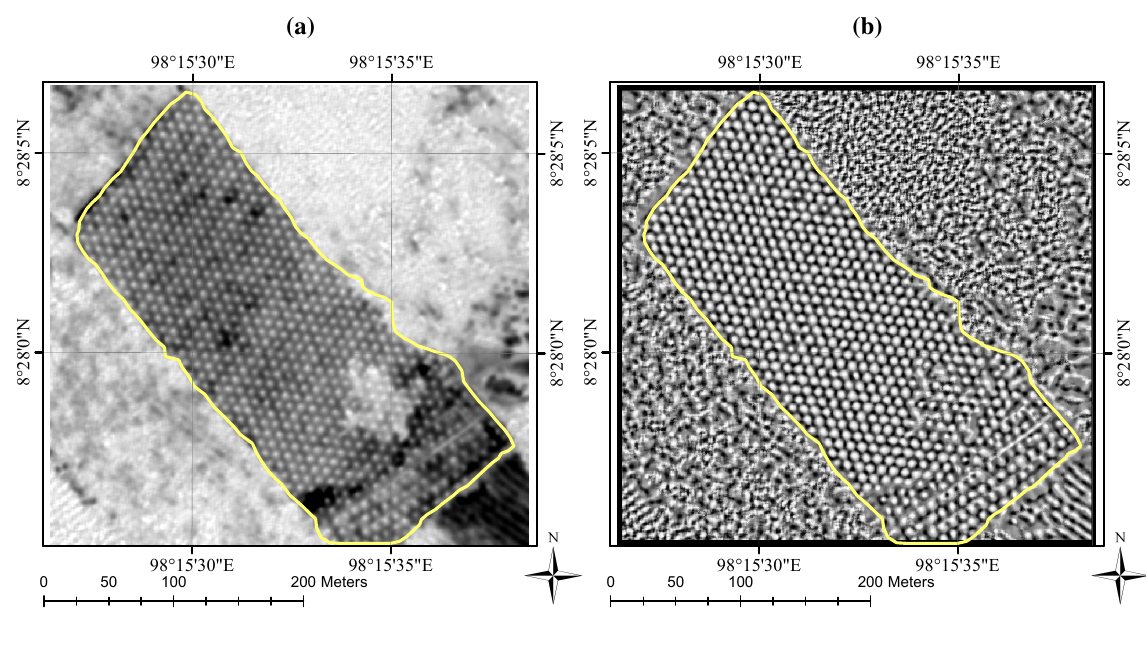
Figure 5. An example of the rank transformation applied to the index image: ( a ) the index image of the data shown in Figure 4a and ( b ) the rank transformation of the index image.